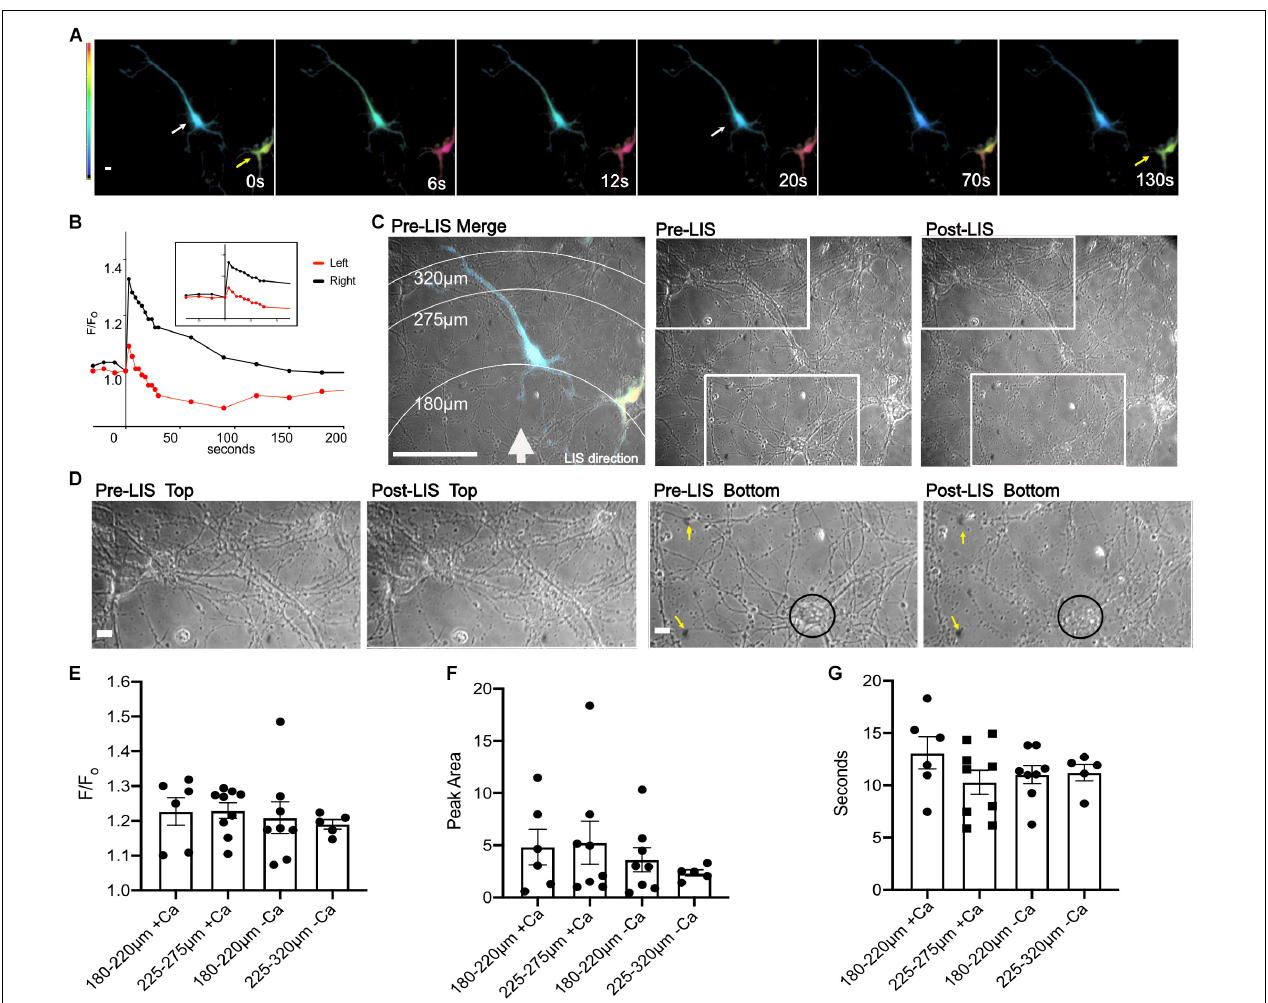
FIGURE 2 | Ratio images of DIV 8 cortical neurons responding to shockwave. (A) Ratiometric images were taken before shockwave t = 0 s and at 6, 12, 20, 70, and 130 s post shockwave. Warmer colors are indicative of greater Ca 2 + . Ratiometric images are not normalized to pre-LIS values therefore colors are indicative of the FRET ratio and not F/F o . The cell on the right (yellow arrow) has a greater FRET ratio and therefore is at a greater Ca 2 + level than the cell on the left (white arrow). Scale bar = 10 µ m (B) A trace of the F/F o for cells shown in (A) . (C) Pre-LIS phase and ratiometric images were overlayed to produce a merged image with concentric rings corresponding to a radius of 180, 275, and 320 µ m from LIS origination. A white arrow depicts the direction of LIS. Scale bar = 100 µ m. Pre-LIS and Post LIS images are shown next to the Merge with two rectangular regions which are enlarged in (D) . Pre-LIS Top and post-LIS top show that cells at that end of the field of view have maintained their morphology after LIS. Scale bar = 10 µ m. Pre-LIS Bottom and post-LIS bottom have yellow arrows pointing to immovable landmarks on the top right and left of the images. A black circle encloses a cell body that has changed drastically after shockwave. (E) F/F o of cells separated by distances and Ca 2 + availability. + Ca indicates cells bathed in regular (1.8 mM) Ca 2 + conditions. -Ca indicates cells in low calcium conditions. N = 6 for 180–220 µ m + Ca, N = 9 for 225–275 µ m + Ca, N = 8 for 180–220 µ m -Ca, N = 5 for 225–275 µ m -Ca, except where noted. (F) Peak Area separated by distances. One cell in regular Ca 2 + and 225–275 µ m from LIS was excluded from the Peak Area analysis since the F/F o decreased to a certain point then remained elevated after shockwave causing the peak area to be very high (74 F/F o *s), N = 8 for 225–275 µ m + Ca. A different cell, outlier in 225–275 µ m + Ca, reached the half maximum and then remained elevated till t = 130 s. (G) T 1 / 2 of cells separated by distances. No significant differences were found between any comparisons in F/F o , peak area, and seconds. Raw values used in the graphs can be found in the Supplementary